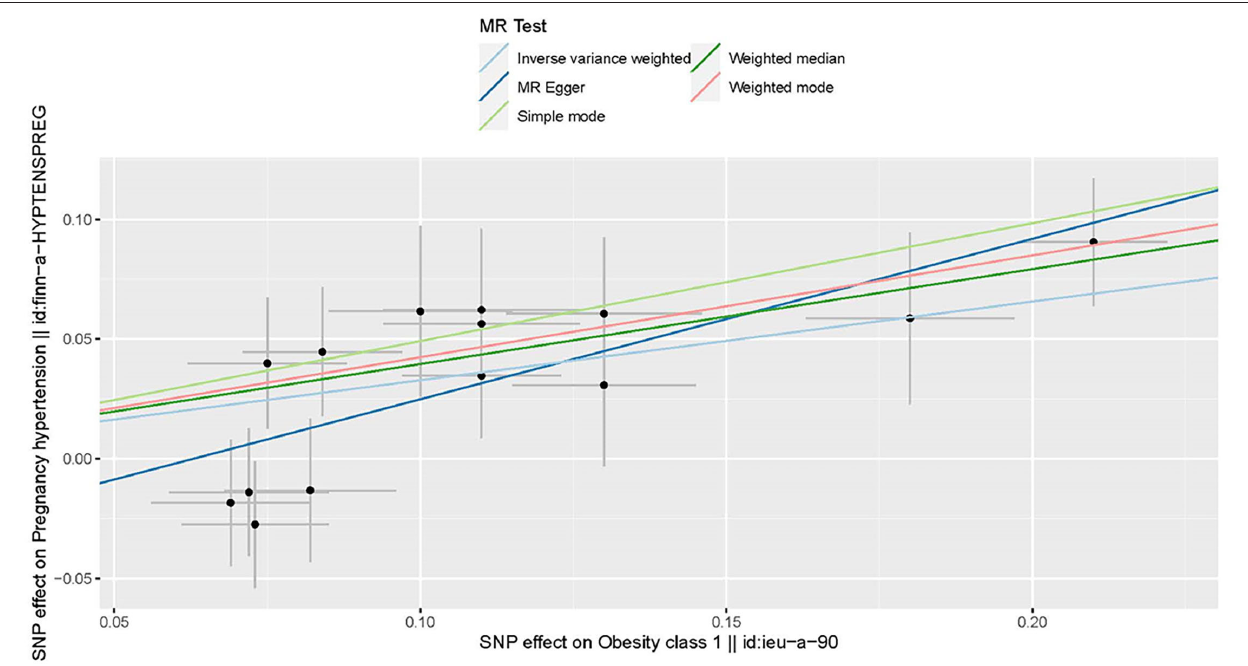
FIGURE 2 | Scatter plot to visualize the causal effect of obesity on the risk of hypertension disorders in pregnancy (HDP). Each black point representing an SNP is plotted in relation to the effect size of the SNP on obesity (x-axis) and on the risk of HDP (y-axis) with corresponding standard error bars. The slope of each line corresponds to the causal estimate using different MR methods. IVW indicates inverse-variance weighted; and MR, Mendelian randomization.